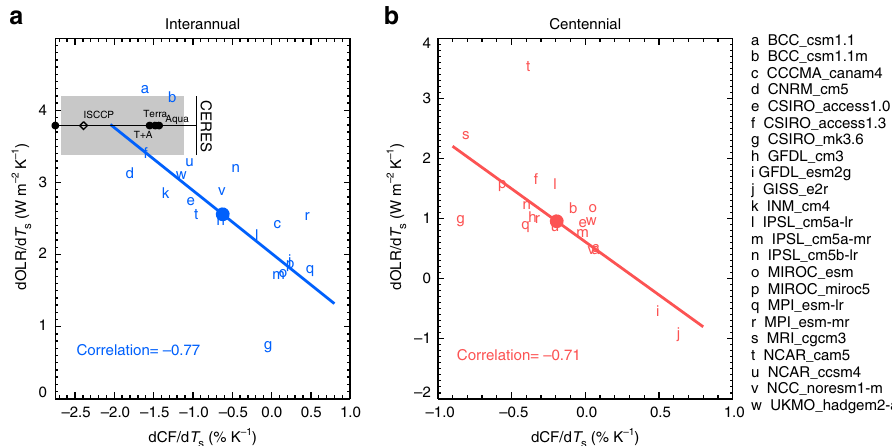
Figure 3 | Relationship between tropical high CF and OLR sensitivities to surface warming. ( a ) Interannual and ( b ) centennial tropical-mean OLR change per unit surface warming dOLR / d T s scattered against tropical-mean high CF change per unit surface warming dCF / d T s for 21 CMIP5 models. Each model is represented by a lowercase letter. Multimodel means are marked in solid coloured circles. The least-squares linear regression lines and correlation coefficients between the x -axis and y -axis variables are shown. The observed dCF / d T s from multiple satellite sensors along with the observed dOLR / d T s from CERES EBAF are shown in black symbols in a . The grey-shaded area marks the uncertainties of the observed data, based on 95% confidence interval of the regression slope between deseasonalized CERES EBAF OLR and HadCRUT4 T s and the range of the observed dCF / d T s from the satellite data used. NATURE COMMUNICATIONS|8:15771|DOI: